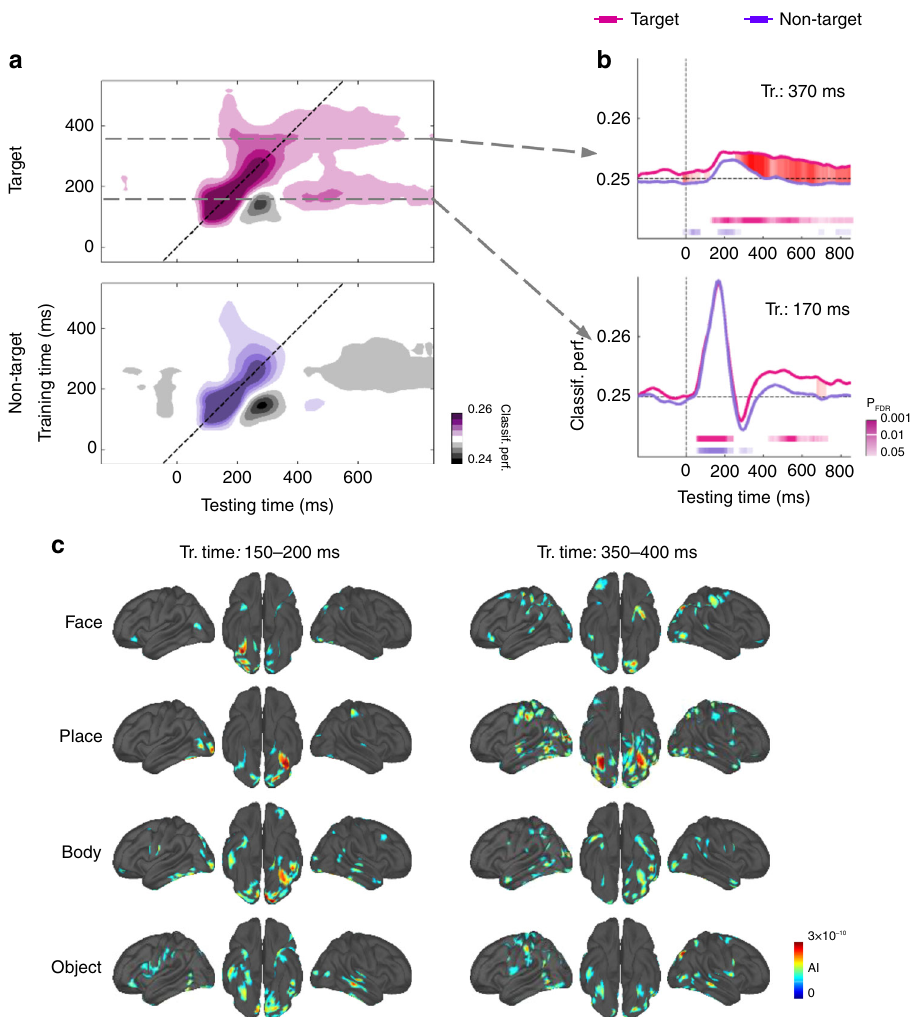
Fig. 3 MEG evidence for two types of target-speci fi c brain responses: sustained activation of sensory processes, and access to an additional late processing stage. a Temporal generalization matrices for target (upper panel) and non-target (lower panel) stimuli averaged across inter-target lags. Gray areas correspond to below chance classi fi cation performance. Dashed arrows represent selected training time depicted in b . b Classi fi cation performance as a function of time for classi fi ers trained at 170 and 370 ms. Results from signed rank tests comparing classi fi cation performance to chance are represented by the thick line below the x axis. Signed rank tests comparing target and non-target conditions are represented by areas fi lled with red, darker colors representing lower P -values. FDR correction for multiple comparisons was applied across speci fi c training times (120 – 370 ms), testing times and conditions. c Source localization of activation patterns computed from the support vector machine (SVM) weights (see method) indicating the location of the most informative activity for each stimulus category; 200 – 250 ms and 350 – 400 ms averaged training times are represented. For display purposes, data points were smoothed using a moving average with a window of three